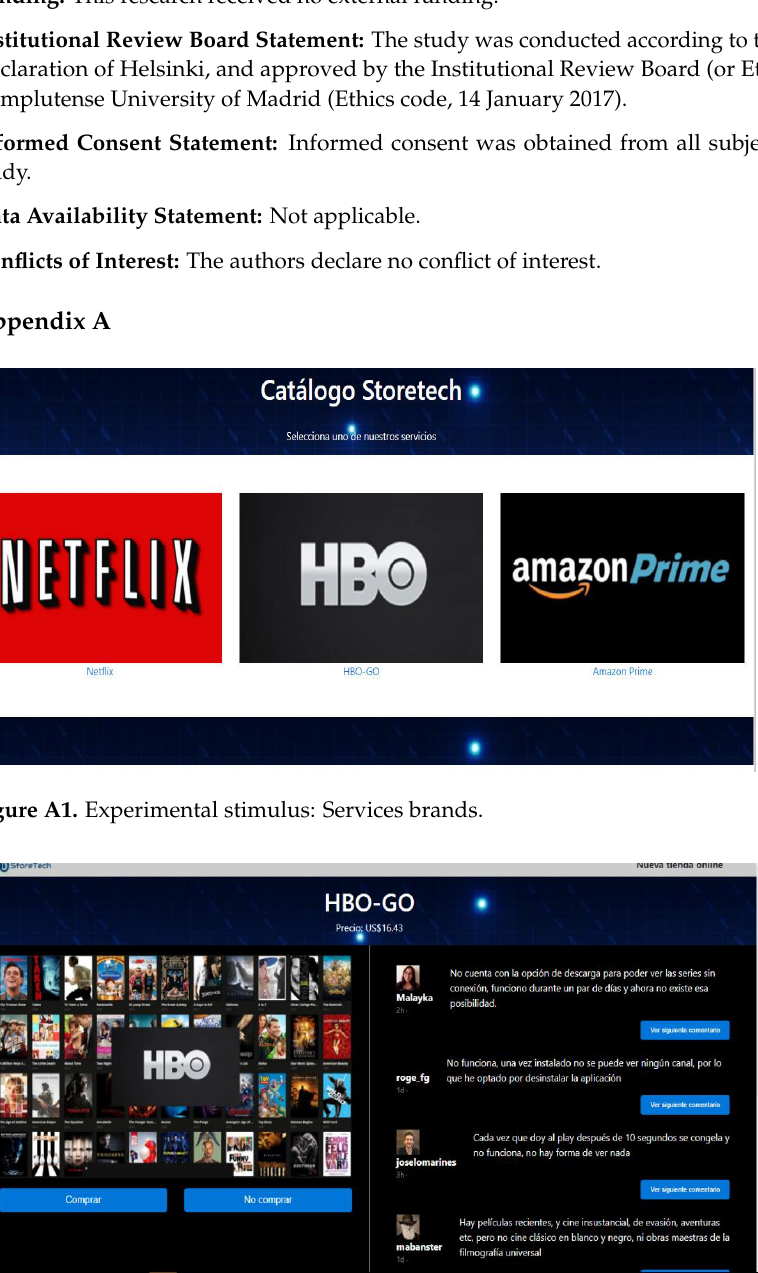
Figure A2. Consumer reviews example.